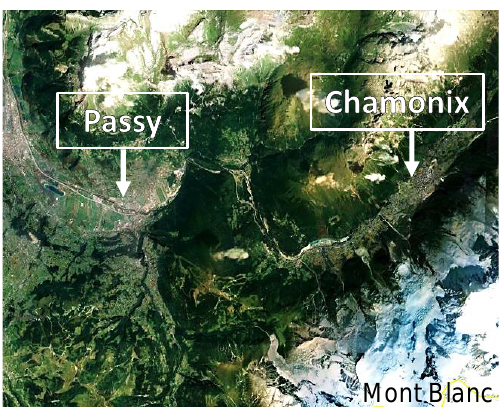
Figure 3. RM 8785 measurements. Black squares and error bars represent values and measurement uncertainties at 2 σ , described in Szidat et al. (2013). The black line stands for the average value and the blue ribbon represents the 2 σ confidence interval for Labs 1–5. The red square shows the weighted average result obtained for this study ( N = 3) and its weighted error (2 σ) . The large scatter could be linked to heterogeneous loading during the production of RM 8785 as mentioned by Cavanagh and Watters (2005). The value ob- tained in this study is compatible with the high end of measurements performed by the five different laboratories.